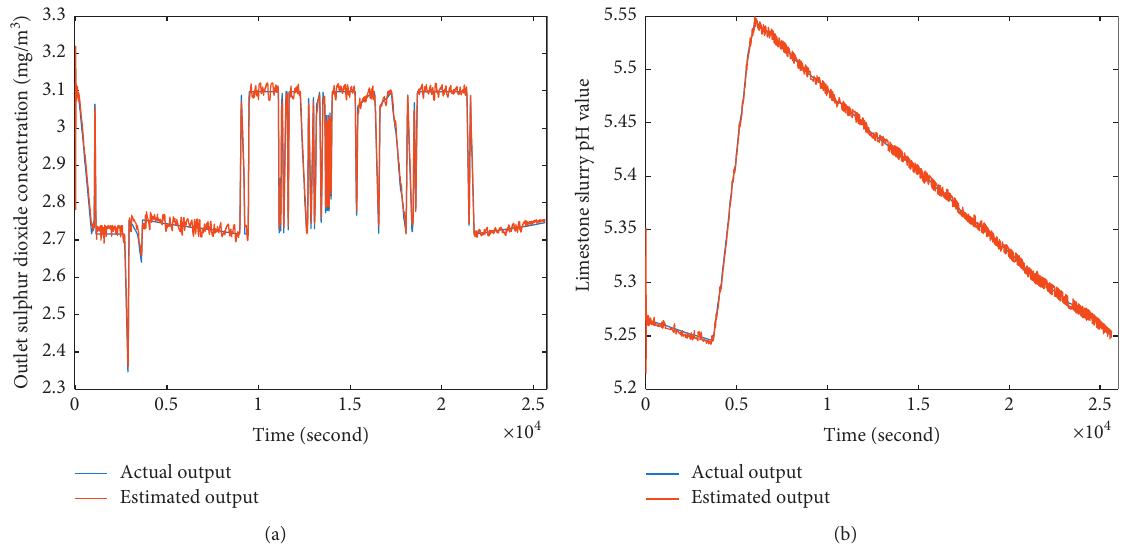
Figure 6: Identification results of dynamic neural network with no hidden layer: (a) result for outlet sulphur dioxide concentration; (b) result for the pH value in slurry.